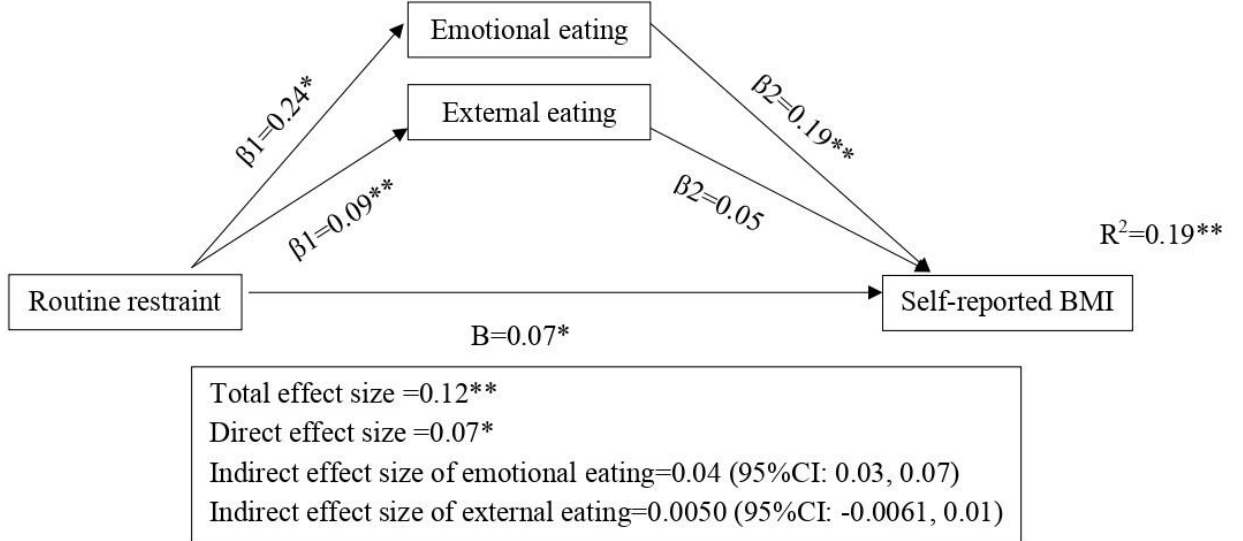
Figure 1. Emotional and external eating as the mediators in the association between routine restraint and self-reported BMI. Standardized beta coefficients (except for R 2 ) are shown on the arrows. The models are adjusted for age and gender. * p < 0.05 ** p < 0.01. Direct and indirect effect size did not add up to total effect size due to rounding.